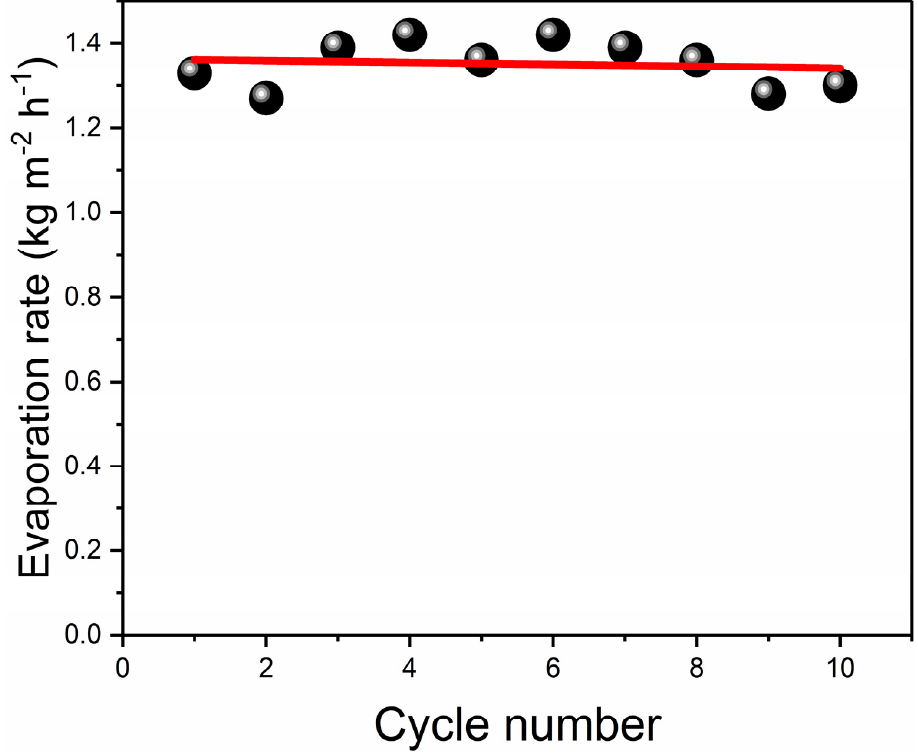
Figure 12. The evaporation rate of RGM on the surface as the function of cycle number.